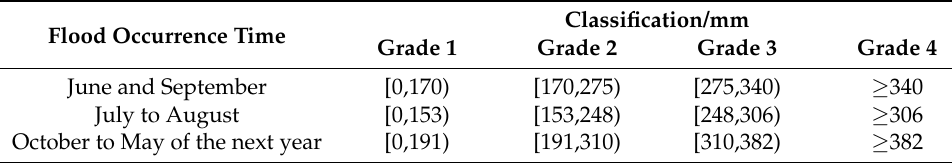
Table 2. Classification of cumulative net rainfall.